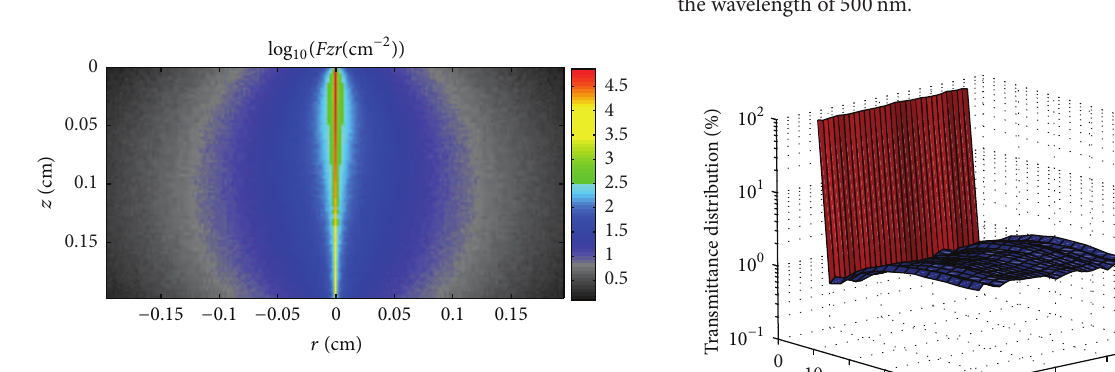
Figure 6: Light propagation in the thermotropic material at 34 ∘ C at the wavelength of 500 nm.